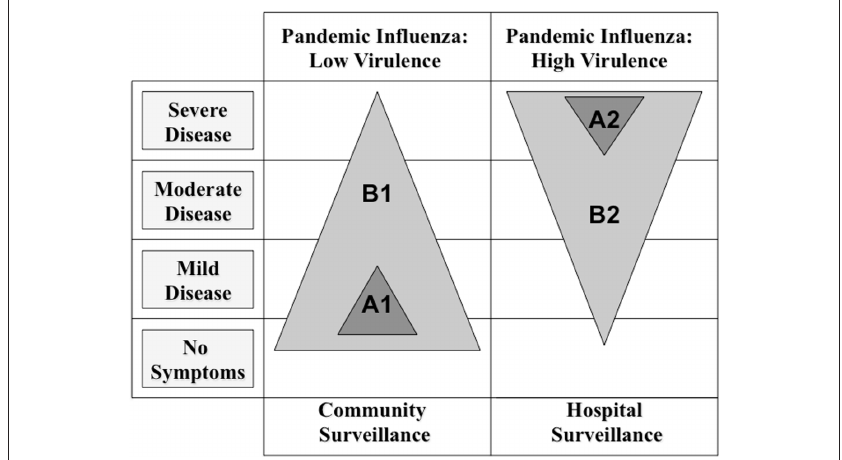
Figure 1 | Disease severity modeling and optimal surveillance approaches for emerging influenza viruses according to viral